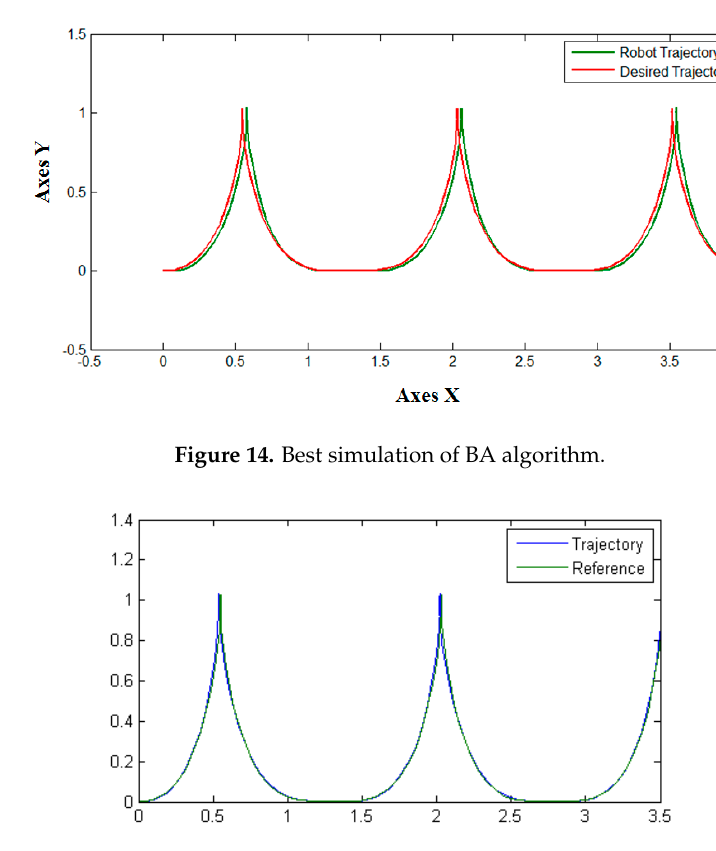
Figure 15. Best simulation of BCO algorithm.